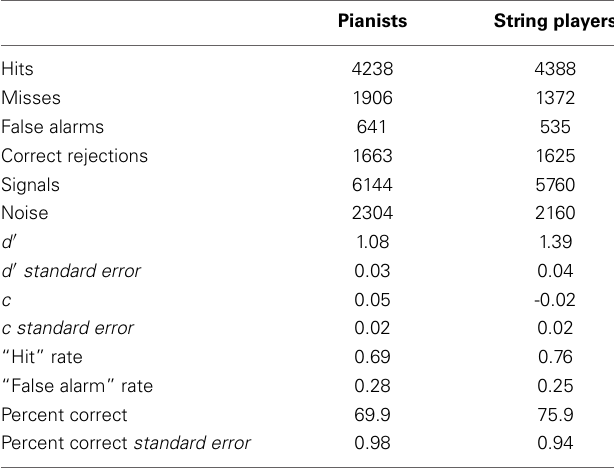
Table 1 | Statistical group-parameters of the SDT analysis of pianists and string players (the replies were pooled over all test